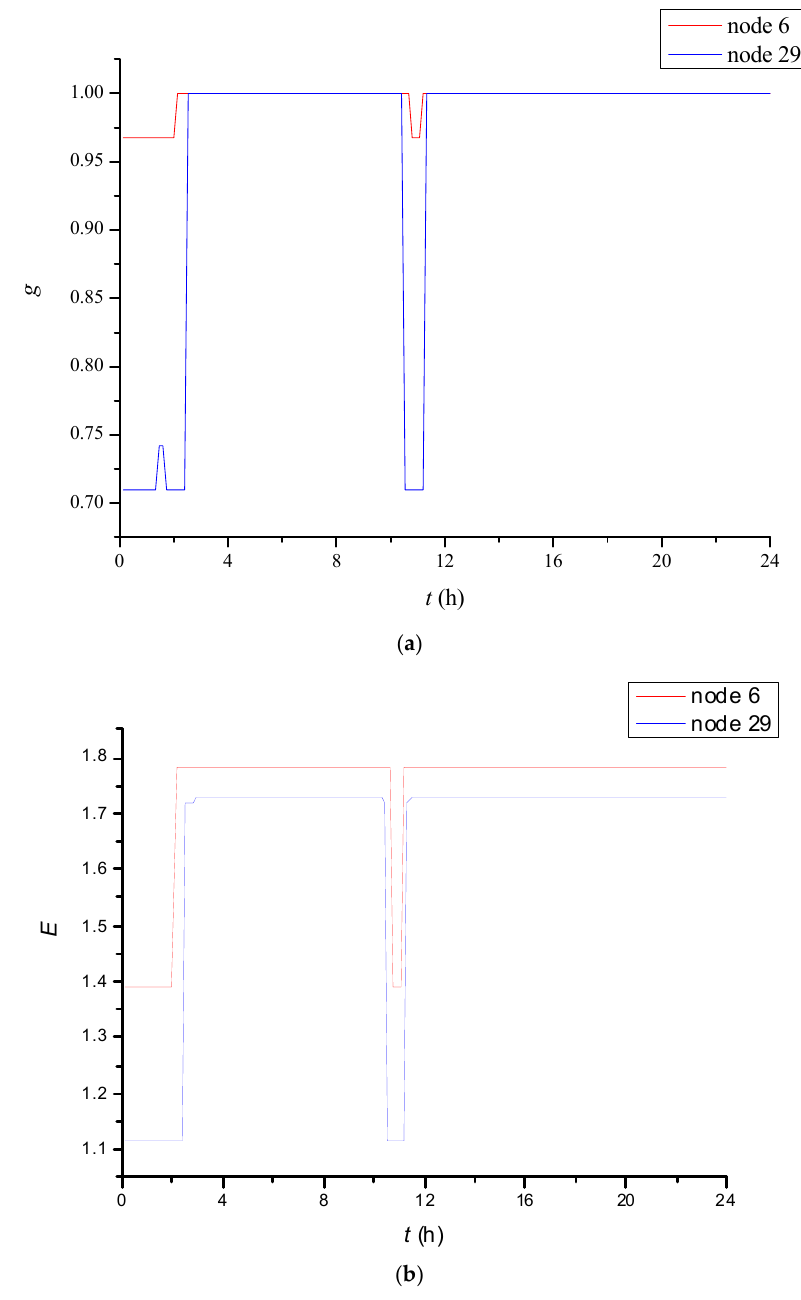
Figure 10. Comparative analysis of the impacts of different wind power coupling locations, ( a ) Connectivity; ( b ) Global effective performance.